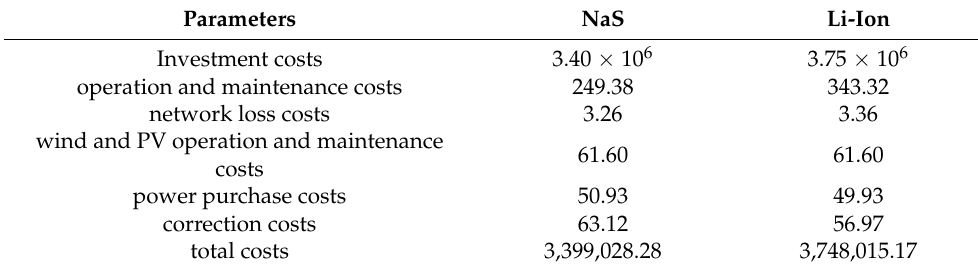
Table 5. Comparison of the three battery storage costs in Scene 3